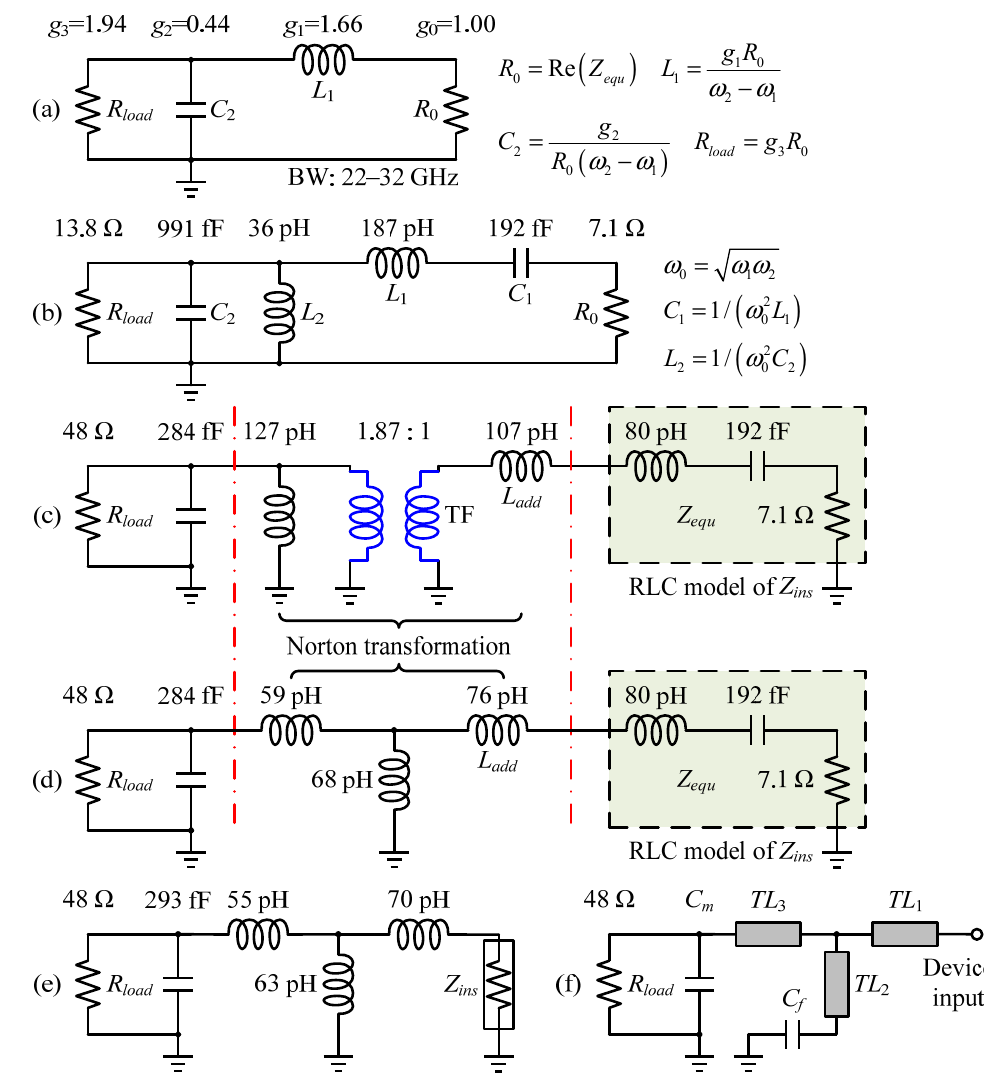
Figure 15. IMN design flow: ( a ) low-pass prototype after impedance and frequency scaling; ( b ) converted band-pass version; ( c ) upward impedance transformation of R load to 48 Ω ; ( d ) Norton transformation to remove the ideal transformer; ( e ) network optimization for realistic Z ins ; ( f ) corresponding ultimate IMN in the mixed-element format.